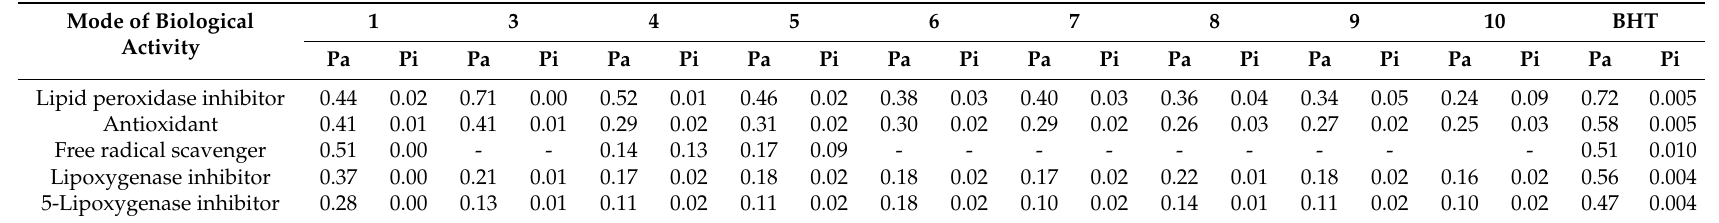
Table 1. PASS prediction of the synthesized compounds 1 , 3 – 10 and